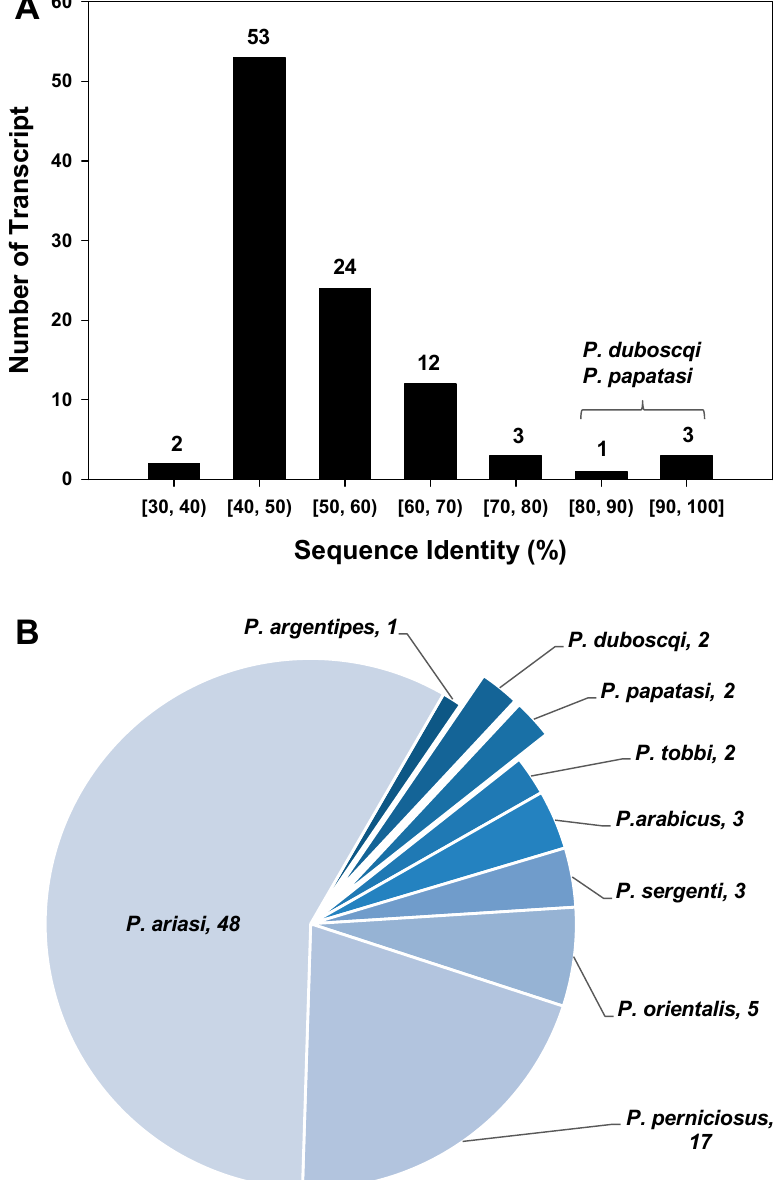
Figure 2. Specificity of P. papatasi salivary apyrase primer set 2. MUltiple Sequence Comparison by Log-Expectation ( MUSCLE ) was used to align and compare the sequence identity of the PCR product generated by the primer set 2 of P. papatasi salivary apyrase with 98 apyrase transcripts in other sand flies. ( A ) The distribution of the number of apyrase transcripts across different range of percent identity; ( B ) The number of apyrase transcripts from different species in Phlebotomus .